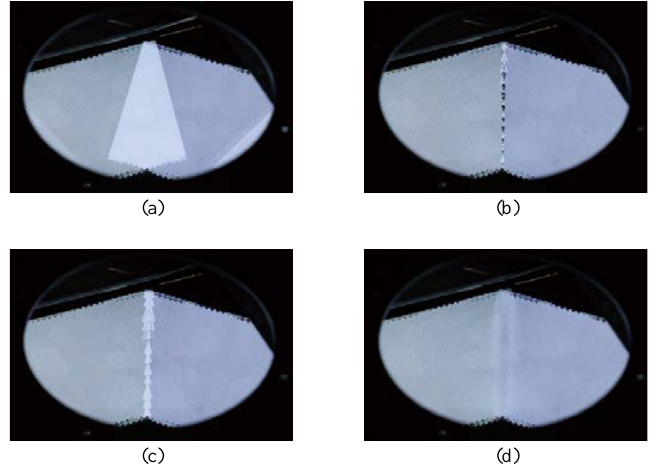
Figure 7. Effects of image stitching technique: ( a ) without image stitching, ( b , c ) with image stitching and without image interpolation, and ( d ) with image stitching and image.